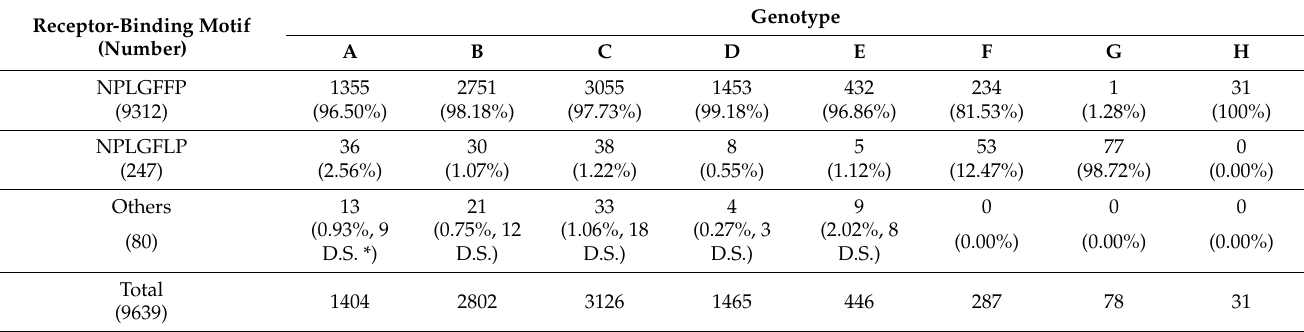
Table 2. The numbers and percentages of the receptor-binding motif with different sequences in the genotypes A–H of HBV. Receptor-Binding Motif